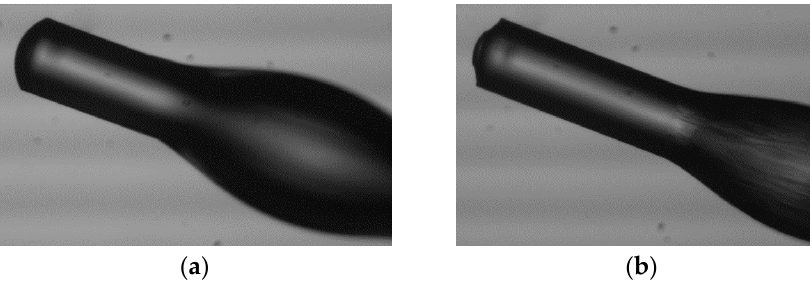
Figure 9. Optical microscope images of the optical fiber with deposited monomer mixture ( a ); polymer flange produced by the back-reflected light on gradient-index MMF by VIS laser with Eosin Y / amine PIS ( b ).